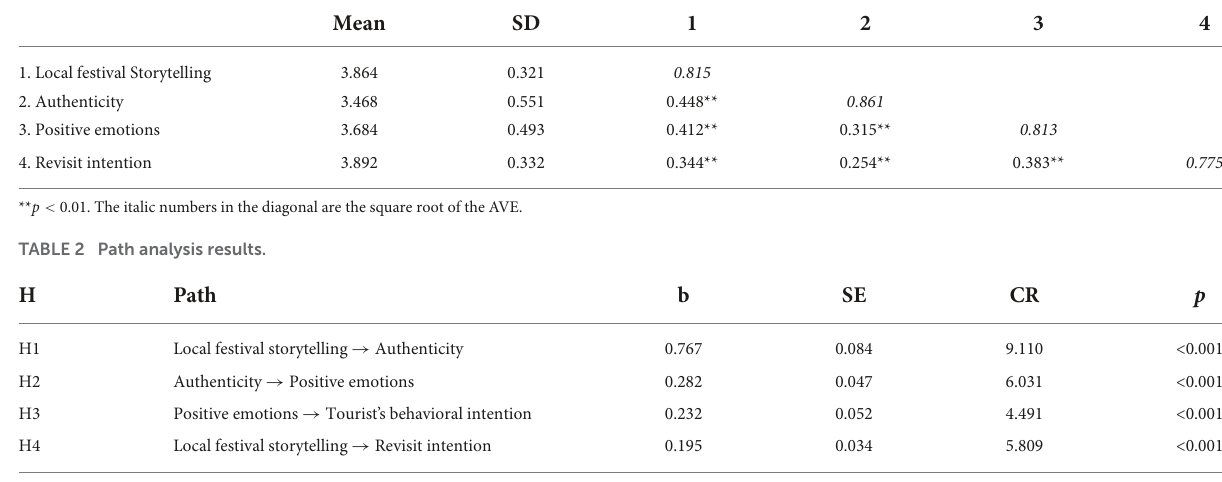
TABLE 3 Indirect effects of the double-mediation impacts (authenticity and positive emotions).